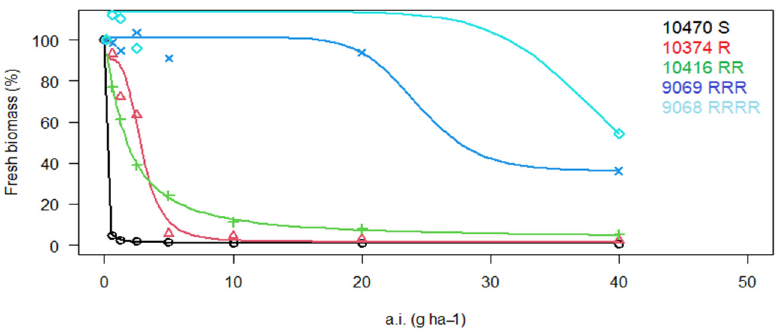
Figure 3. Dose-response curves of P. rhoeas populations resistant (R, RR, RRR, RRRR) and susceptible (S) to iodosulfuron-methyl-Na.